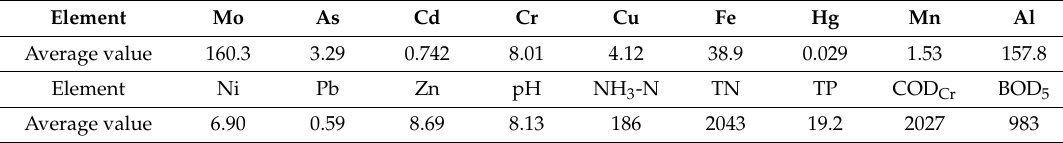
Table 2. The water quality parameters of a reservoir / µ g · L − 1